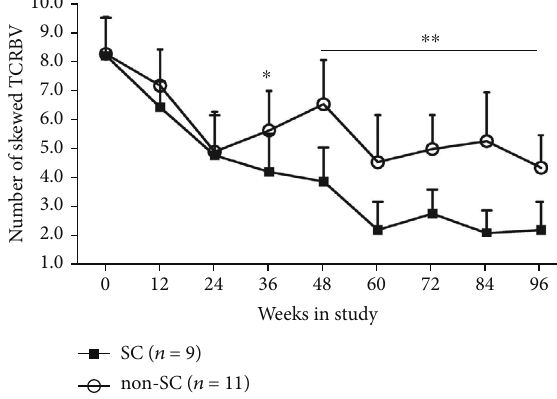
Figure 1: Dynamic change number of skewed TRBV families in CHB subjects with HBeAg seroconverting (SC) and non-SC during TDF treatment for 96 weeks. The number of skewed TRBV families was calculated by complying with the criteria listed in Methods. ∗ P < 0 : 05 and ∗∗ P < 0 : 01 , the number of skewed TRBVs in HBeAg SC subjects compared to those in non- SC subjects at the same treatment time point. This signi fi cant di ff erence began at week 36 and was analyzed using nonparametric